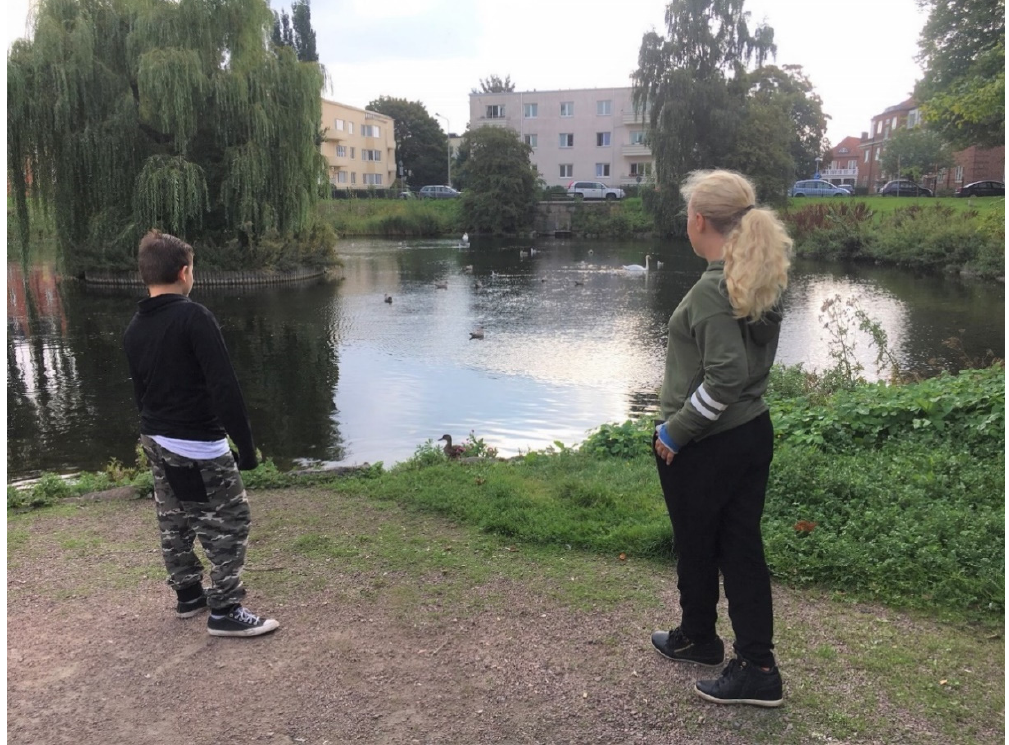
Figure 4. Several children were attracted to the pond to watch the birds.